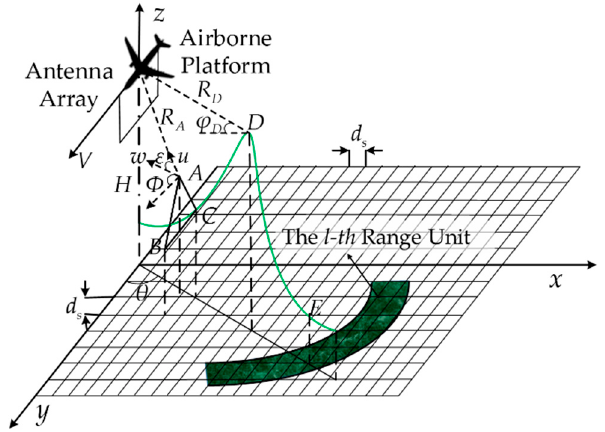
Figure 1. Ground clutter model of airborne phased array PD radar.